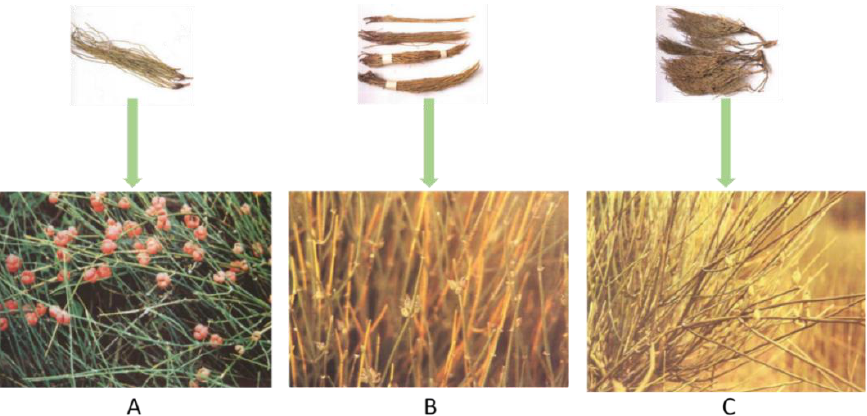
Figure 1. Three types of Ephedra listed in the 2020 edition of the Pharmacopoeia of the People’s Republic of China : ( A ) Ephedra sinica Stapf; ( B ) Ephedra intermedia Schrenk et C. A. Mey; ( C ) Ephedra equisetina Bge).